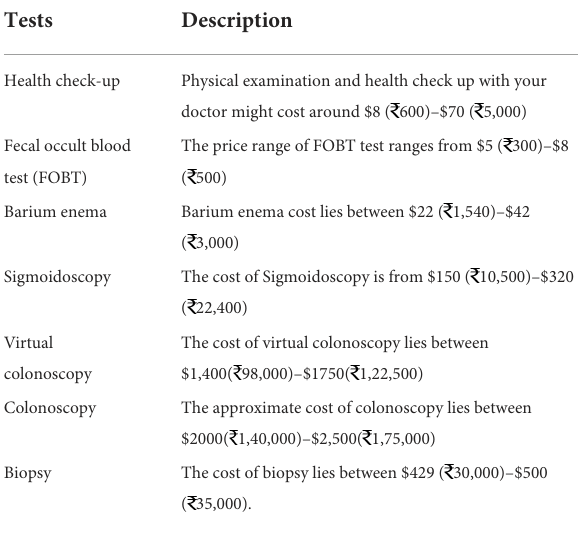
TABLE 1 Expected cost of tests and pre-colon cancer treatment in